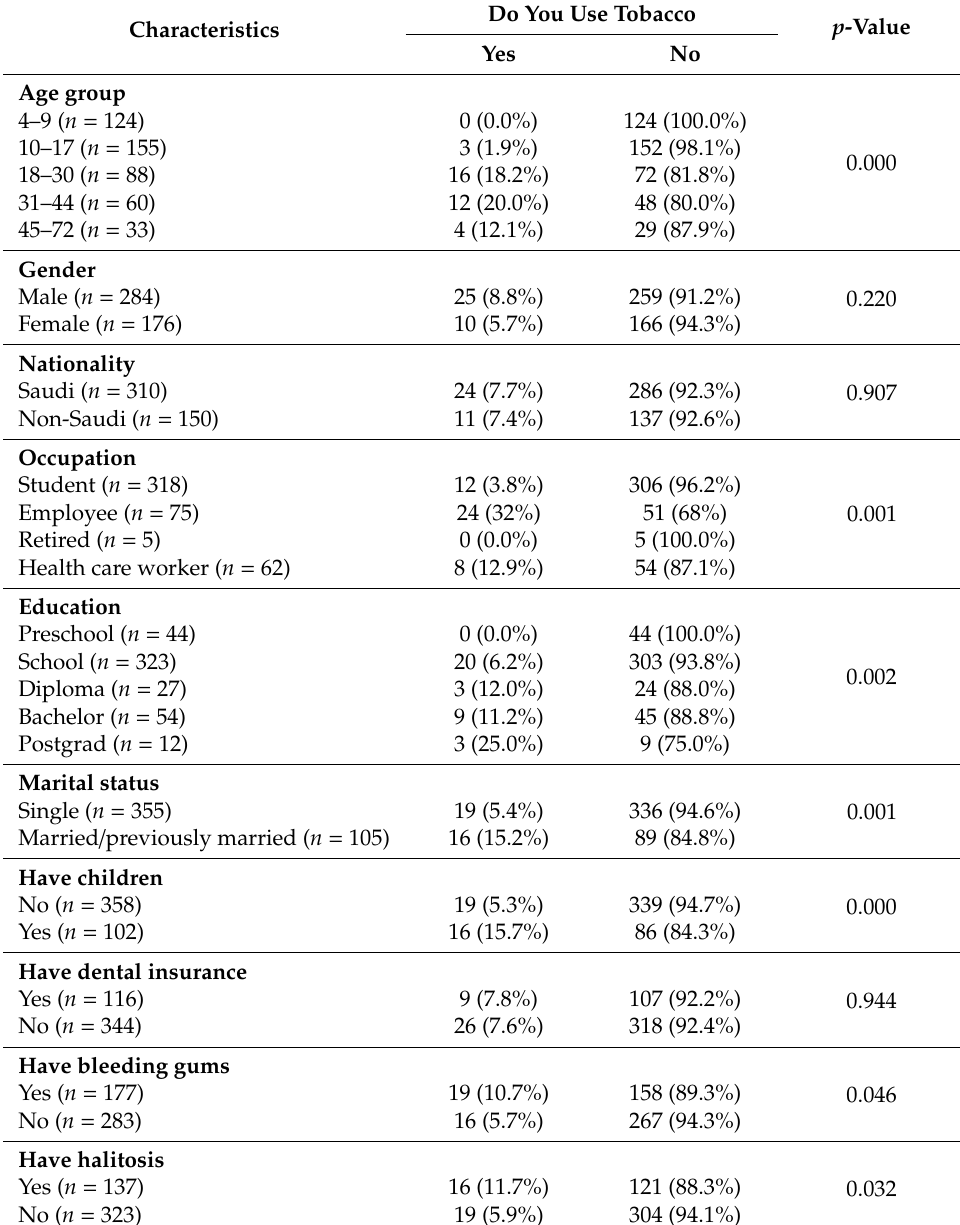
Table A2. Cross tabulation of tobacco use and various